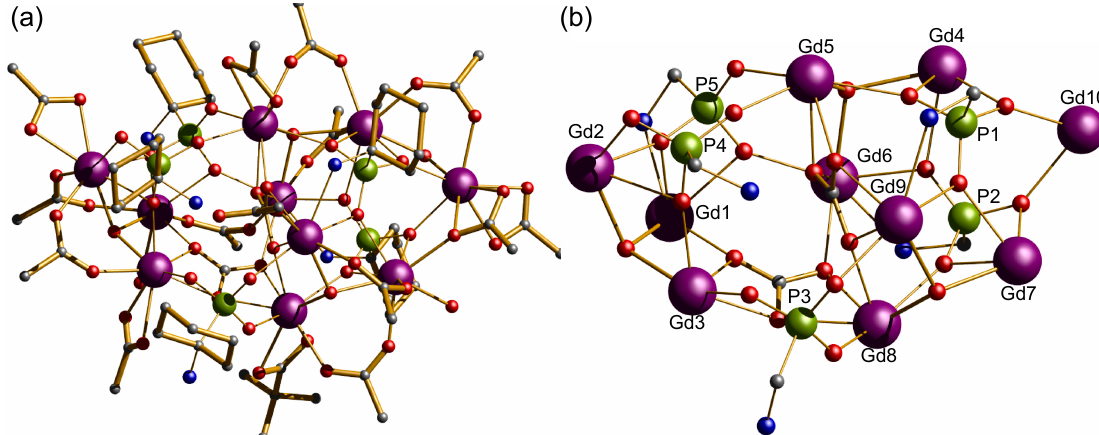
Figure 1. ( a ) Crystal structure of {Gd 10 P 5 } cluster. Scheme: Gd, purple; P, green; O, red; C, grey; N, cyan; (H-atoms and Me groups omitted for clarity); ( b ) metal and phosphonate core in {Gd 10 P 5 }, showing μ 3 -OH centerd metal ions and carbonate moieties.